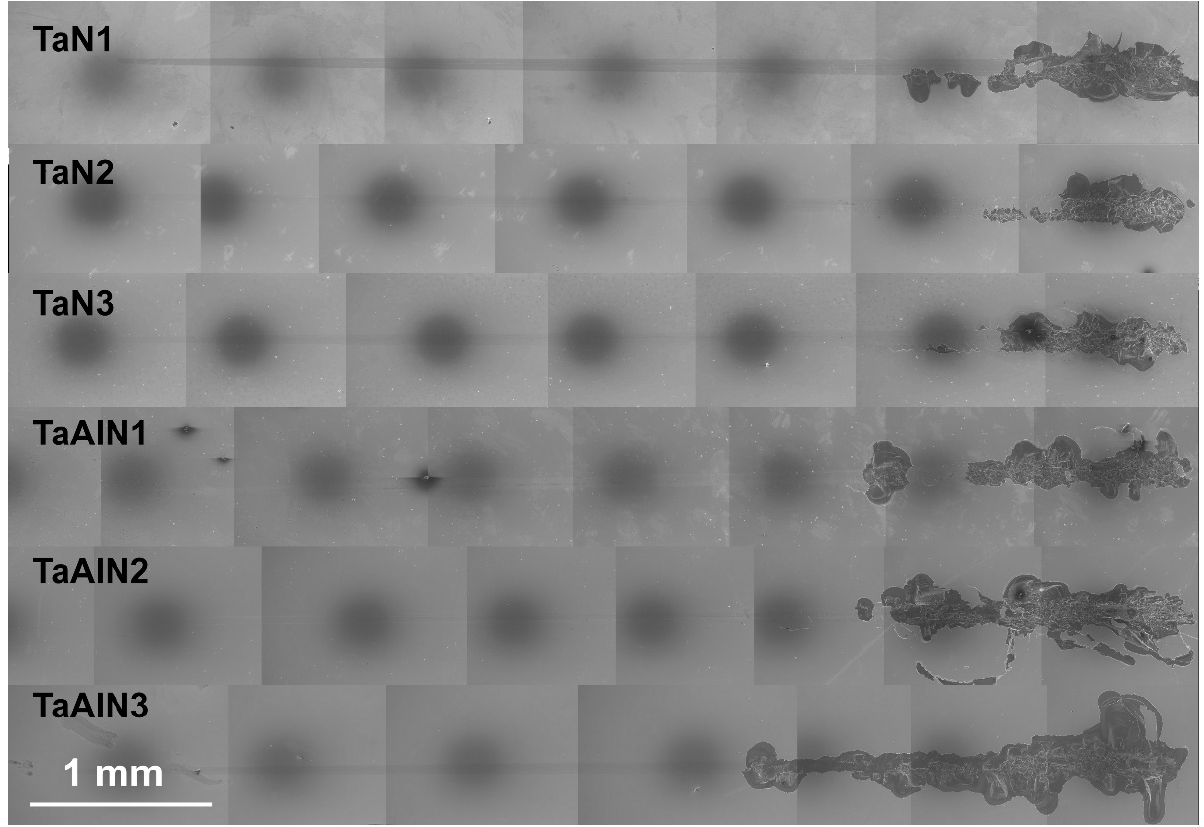
Figure 8. Scratch scars of TaN and TaAlN coatings.